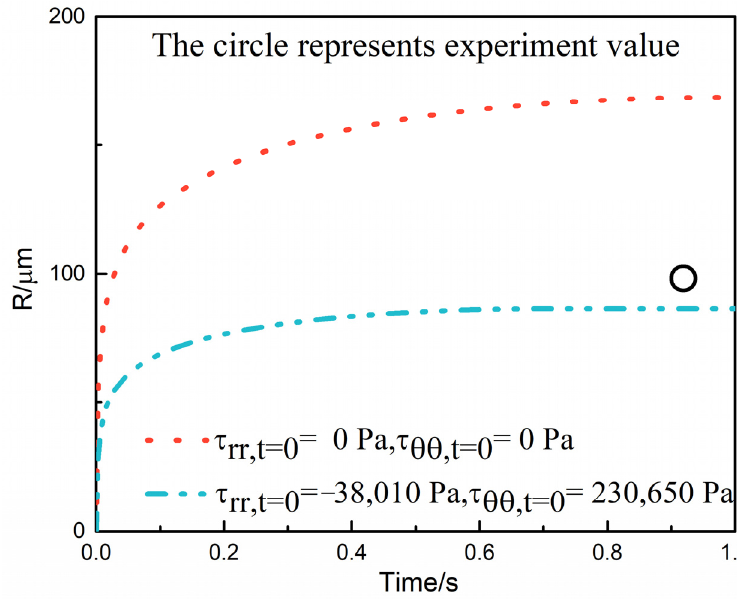
Figure 14. Effect of initial melt stress on bubble growth of PF271.